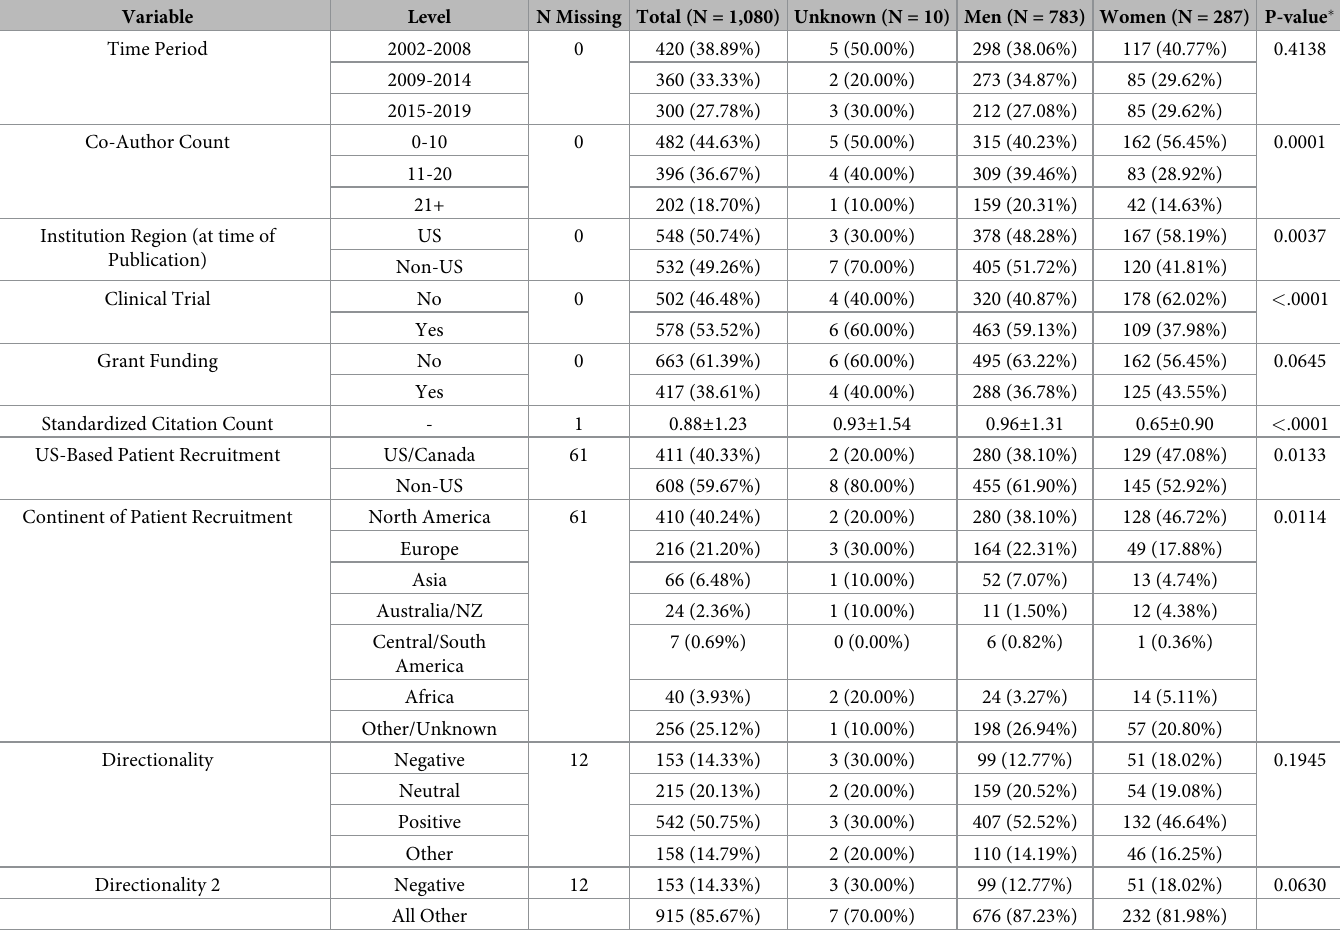
Table 2. Top medical research journals: First authors’ publication’s characteristics by gender (2002 to 2019).